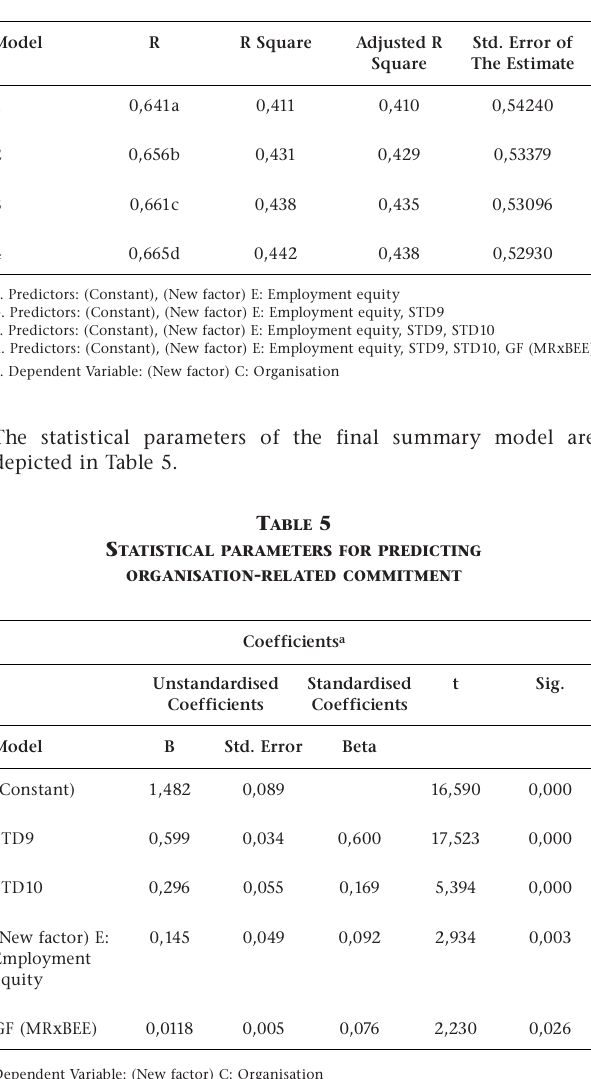
Figure 11: Graphical representation of the predictors